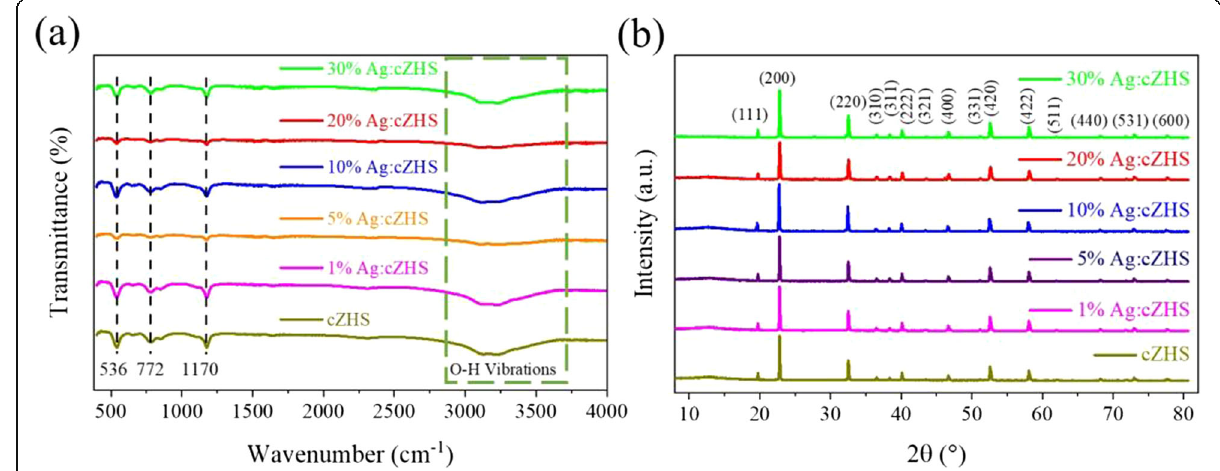
Fig. 3 FTIR spectrum ( a ) and XRD patterns ( b ) of cZHS, and Ag:cZHS